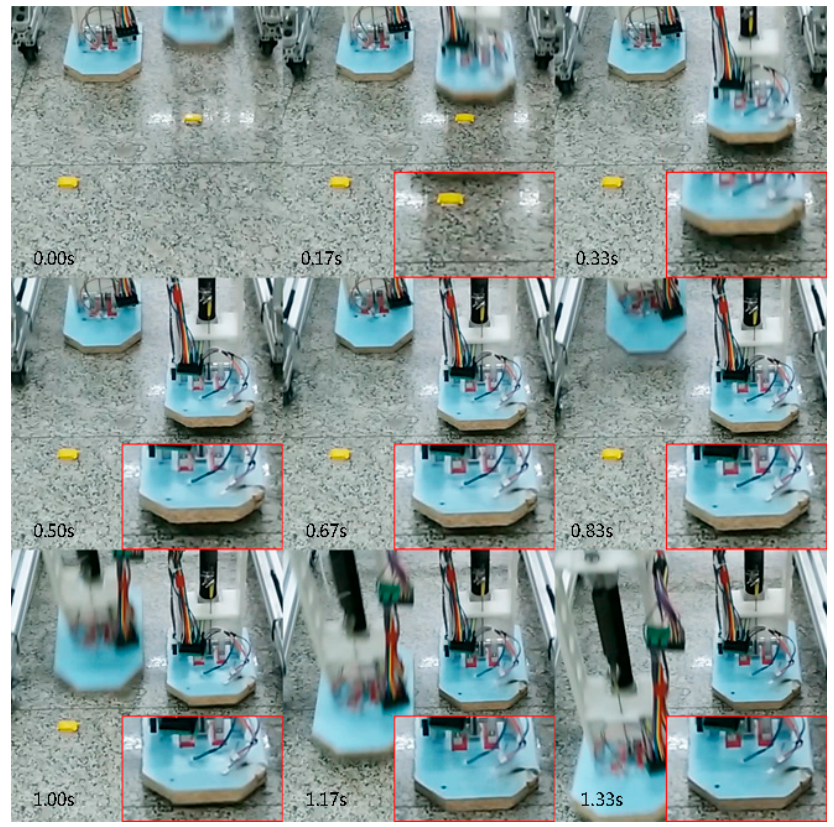
Figure 14. Screenshots of the flat foot contacting with the bumps on the ground during walking.